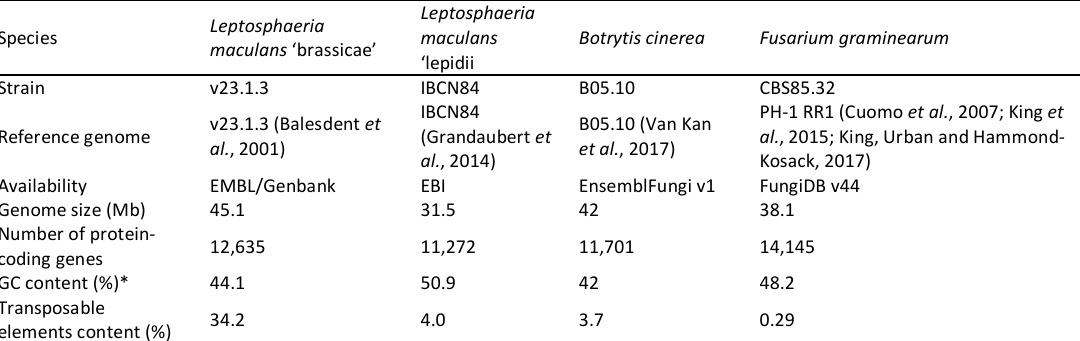
Table 1: Characteristics of reference genomes for the four fungal species